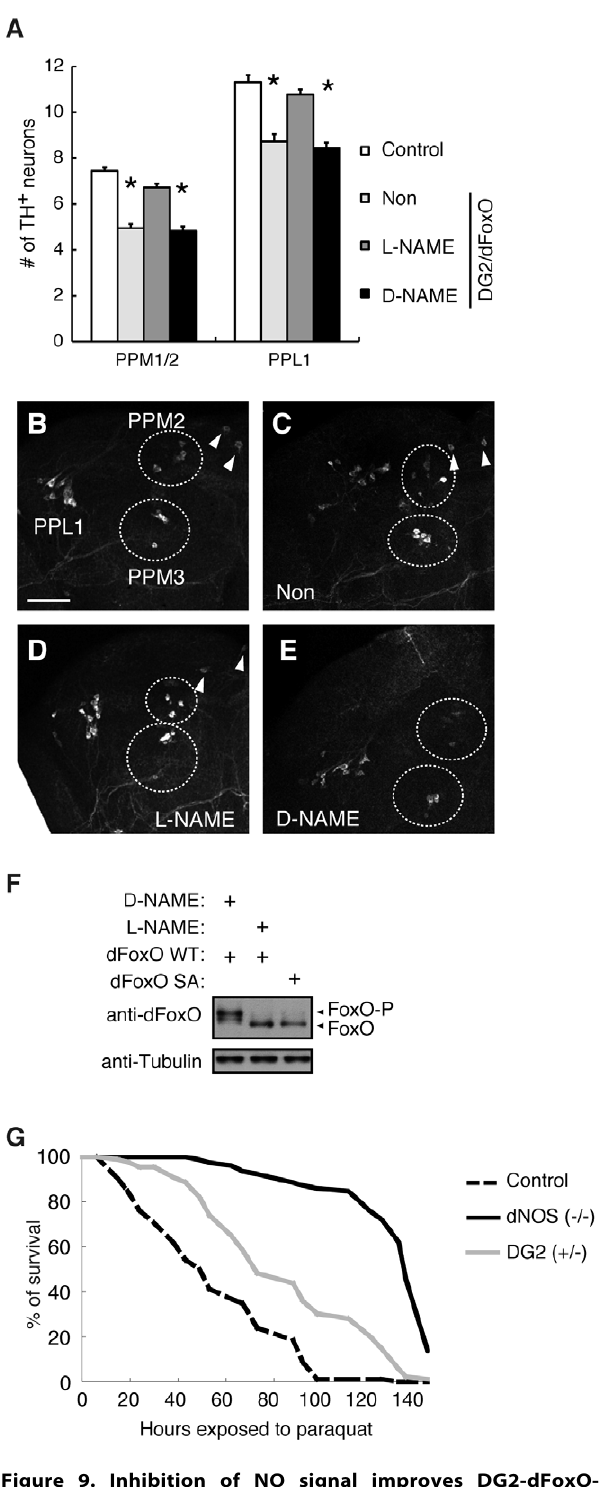
Figure 9. Inhibition of NO signal improves DG2-dFoxO- mediated DA neurodegeneration. ( A ) Newly eclosed normal w- flies (Control) or transgenics harboring elav-GS . UAS-dFoxO/UAS-DG2 ( n =22 in each) were fed a yeast paste containing 50 m g/mL_ RU486 with or without 10 mM L-NAME or D-NAME every 4 days at 29 u C. The graph presents the number of PPM 1/2 and PPL1 clusters of TH-positive neurons in 20-day-old adult flies. PPM1 and PPM2 clusters were counted together. Data are presented as the mean 6 SE for three experiments (*, p , 0.05 vs. Control). PPL, the protocerebral posterior lateral. Non; RU486 only. ( B ) A representative image of